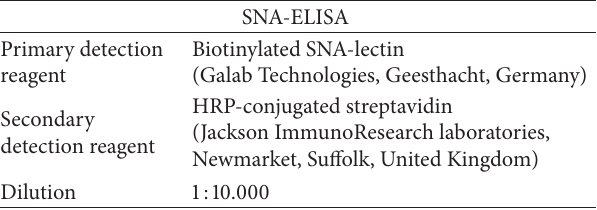
Table 2: Detection reagents for lectin ELISA. SNA-ELISA